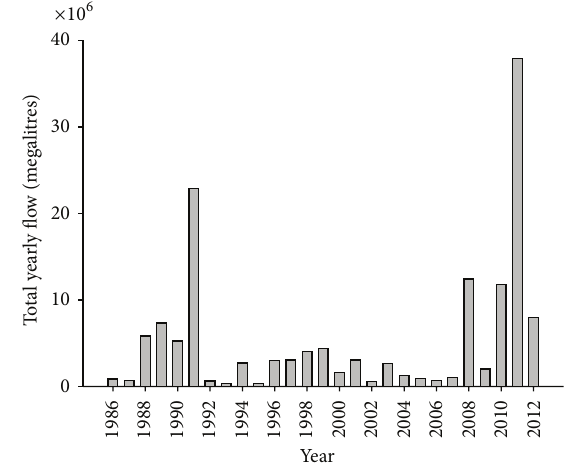
Figure 4: Total annual flow in megalitres for the Fitzroy River measuredin“wateryears”at“TheGap”monitoringsite.Awateryear runs from 1 October of the preceding calendar year to 30 September; for instance, the bar for 2012 water year in the figure represents total flow measured at “The Gap” between October 2011 and September